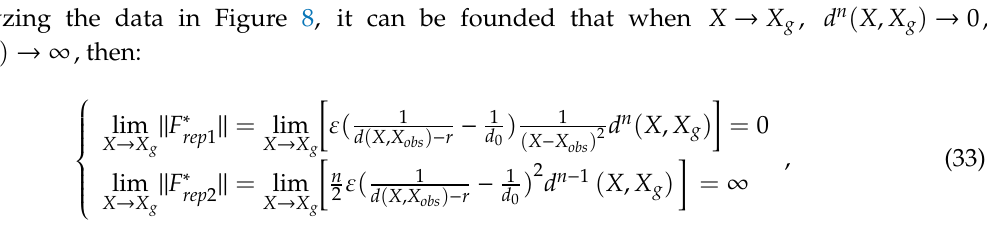
Figure 8. Mathematical characteristics when 0 < n < 1